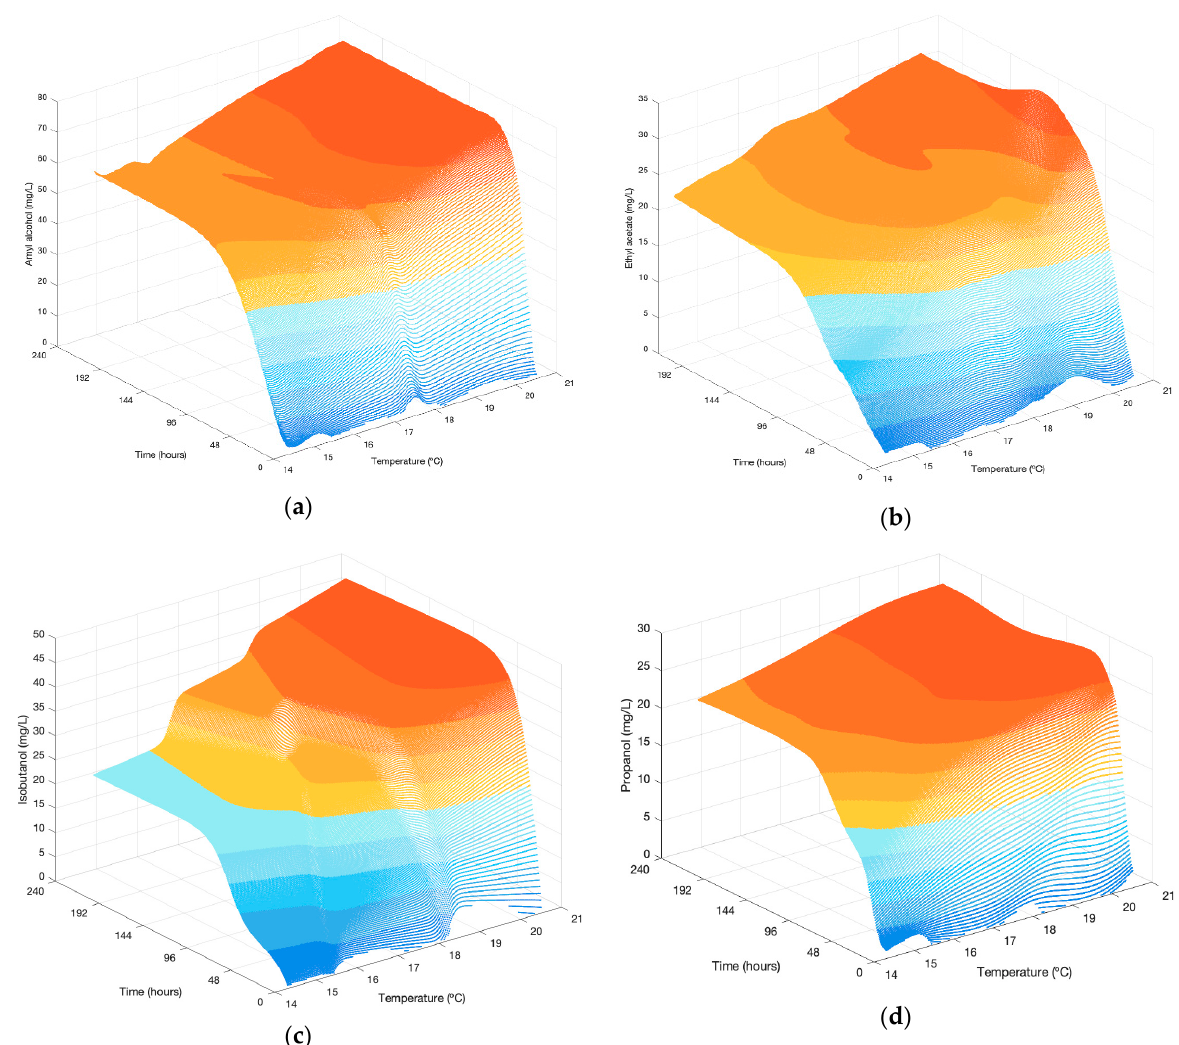
Figure 6. Scatter graphs of predicted values by ANNs: ( a ) amyl alcohol; ( b ) ethyl acetate; ( c ) isobutanol; ( d ) n-propanol.